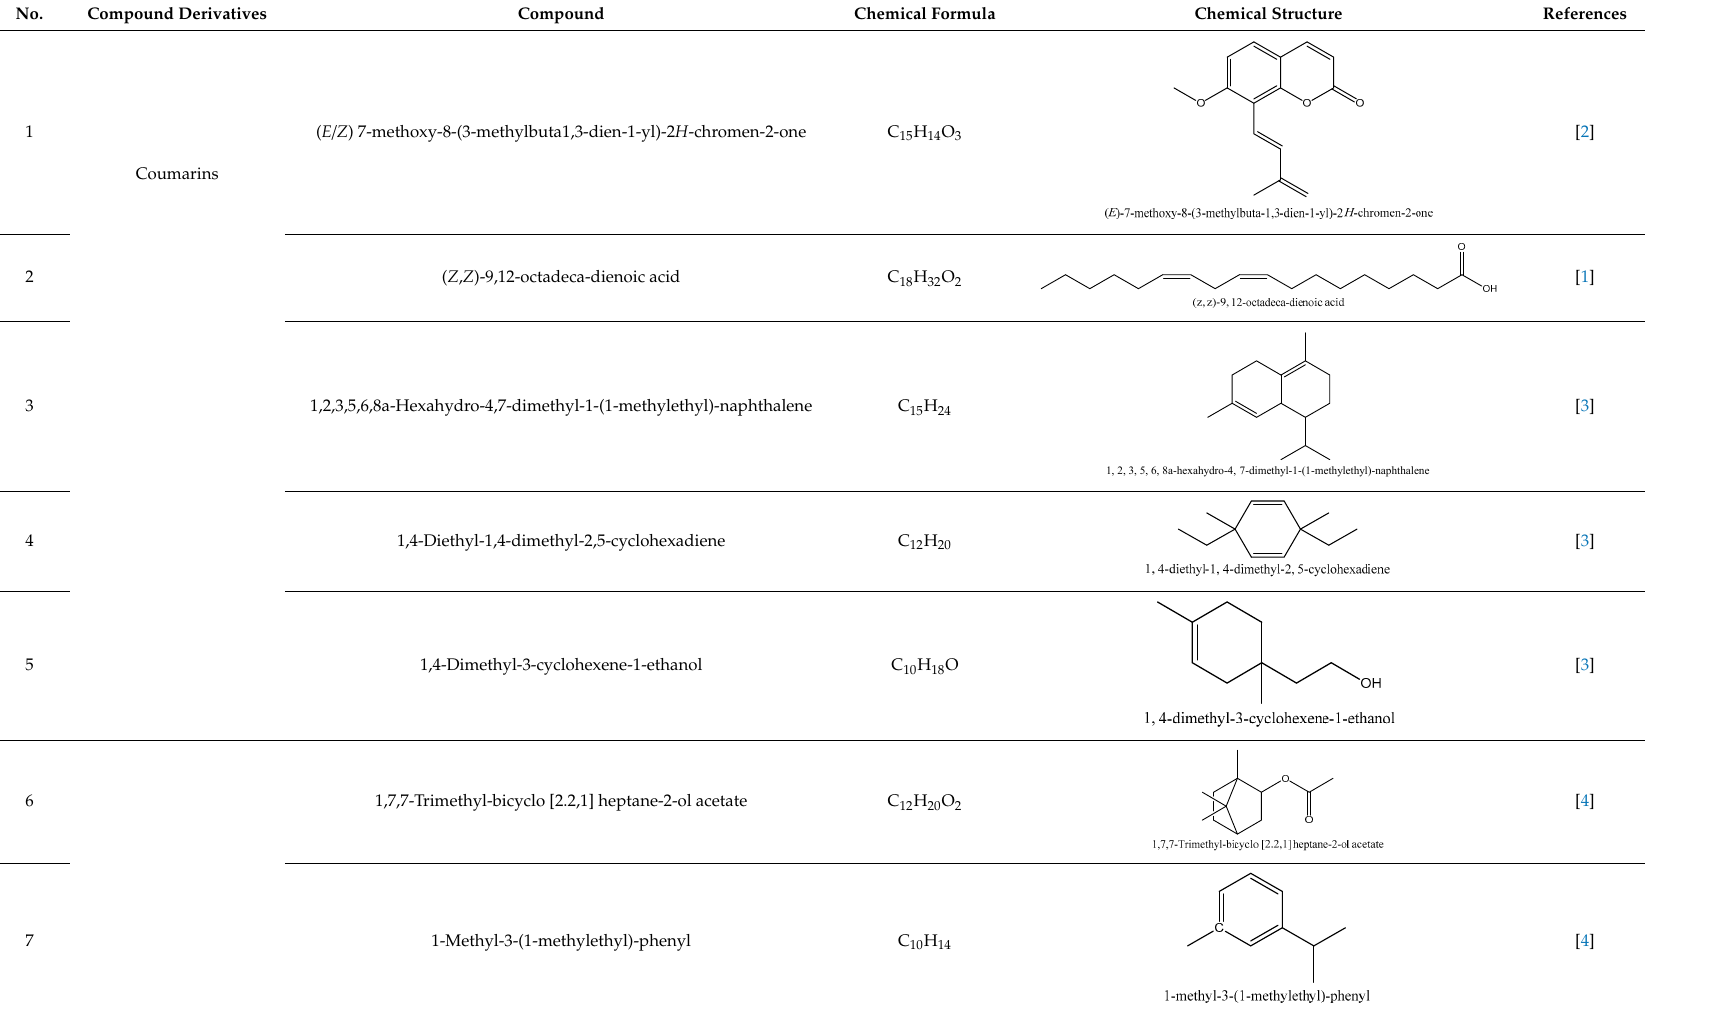
Table 1. Molecular formula and chemical structures of compounds derived from Cnidium monnieri (L.) Cusson (80 in total, 56 with chemical structures). No.